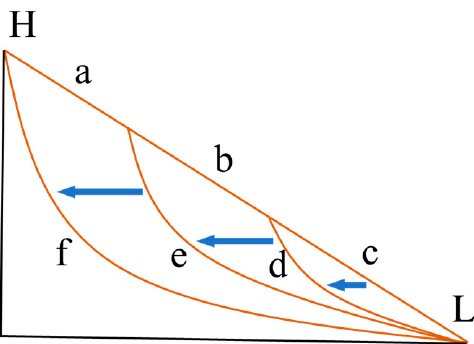
Figure 1. Water erosion evolution. H and L indicate the upper and lower points of the water flow path, respectively. a–f indicate the edges (colored orange) of the water flow path. Blue arrows indicate the evolution of the water confluence line.